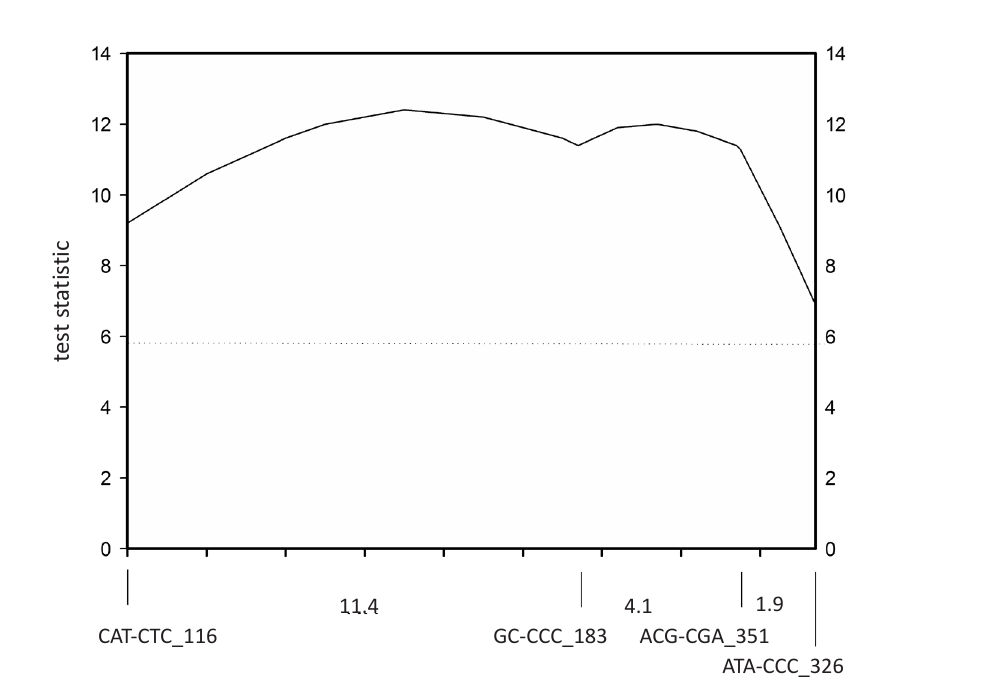
Fig.2. QTL likelihood map of a linkage group harboring a locus for Typhula resistance in the F progeny of the timothy cross Tammisto II x Nosappu. The dashed line indicates 1 the test statistic threshold of 5.8.